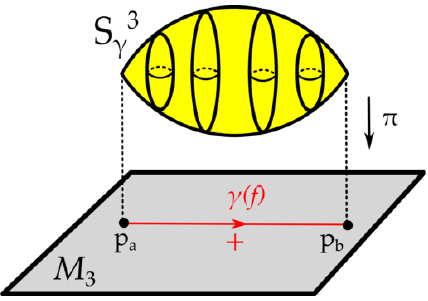
Figure 4 . The supersymmetric three-cycle responsible for mass terms. The two critical points p a and p b of the function Morse f in the base of the ALE-(cid:12)bration M 3 are connected by a gradient (cid:13)ow line (cid:13) ( f ). Above each point along this path there is a two-spheres in the ALE (cid:12)ber. Traversing along a gradient (cid:13)ow line of f a 3-sphere S 3 is traced out. (cid:13) paths connecting two critical points lifts to a 3-sphere in the ALE geometry. This 3-sphere is of minimal volume whenever it projects to a gradient (cid:13)ow line in M . This is depicted 3 in (cid:12)gure